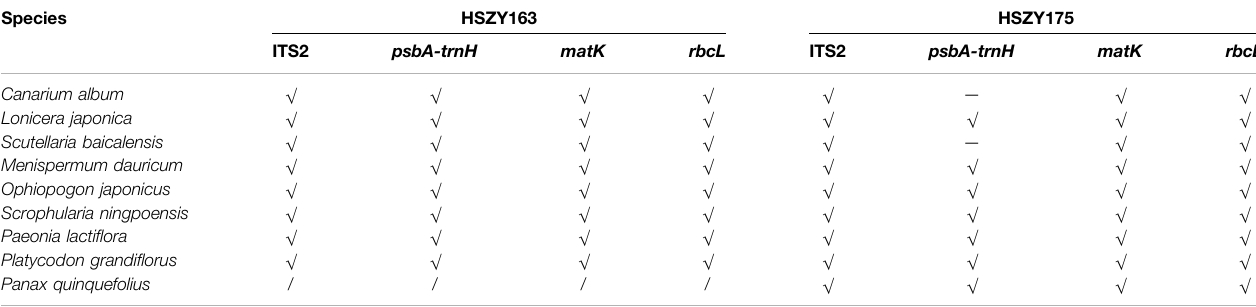
TABLE 4 | The species detection of the ITS2, psbA-trnH , matK, and rbcL DNA barcoding regions obtained via shotgun